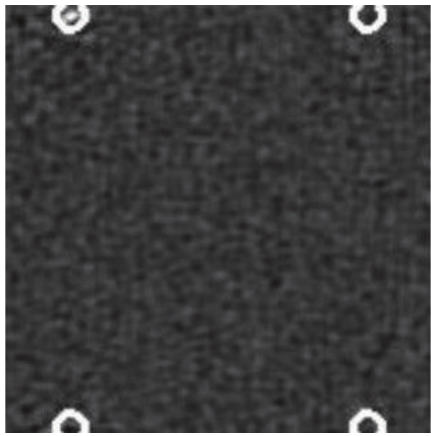
Figure 28: Normalized cross-correlation image in the color space with a marked global peak in it (upper left